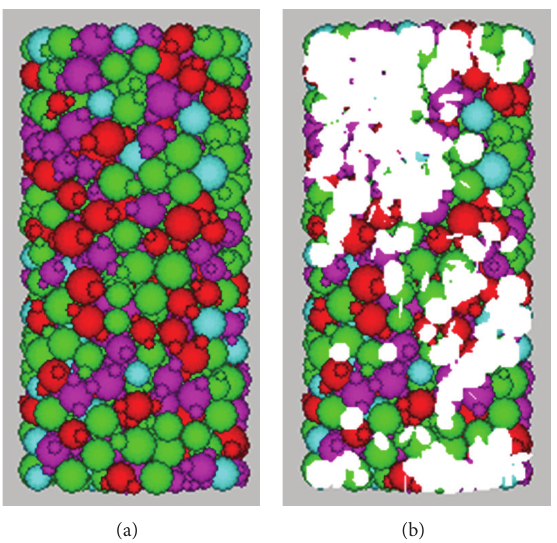
Figure 6: The samples before and during the numerical test.